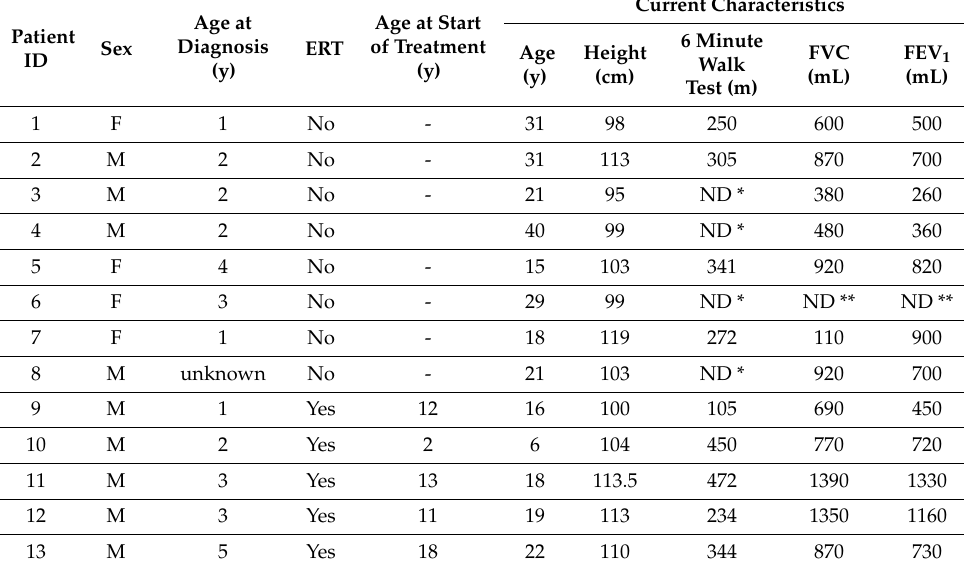
Table 1. Demographics of MPS IVA